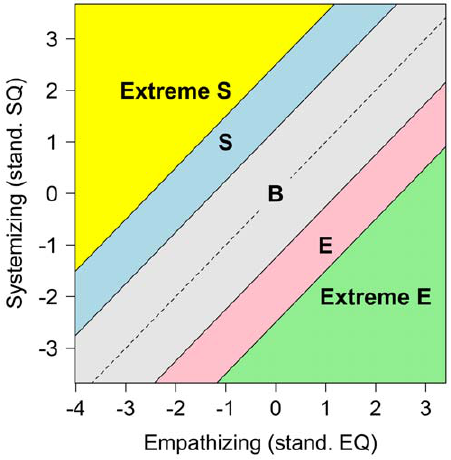
Figure 1. Using the difference between EQ and SQ for classifying cases.